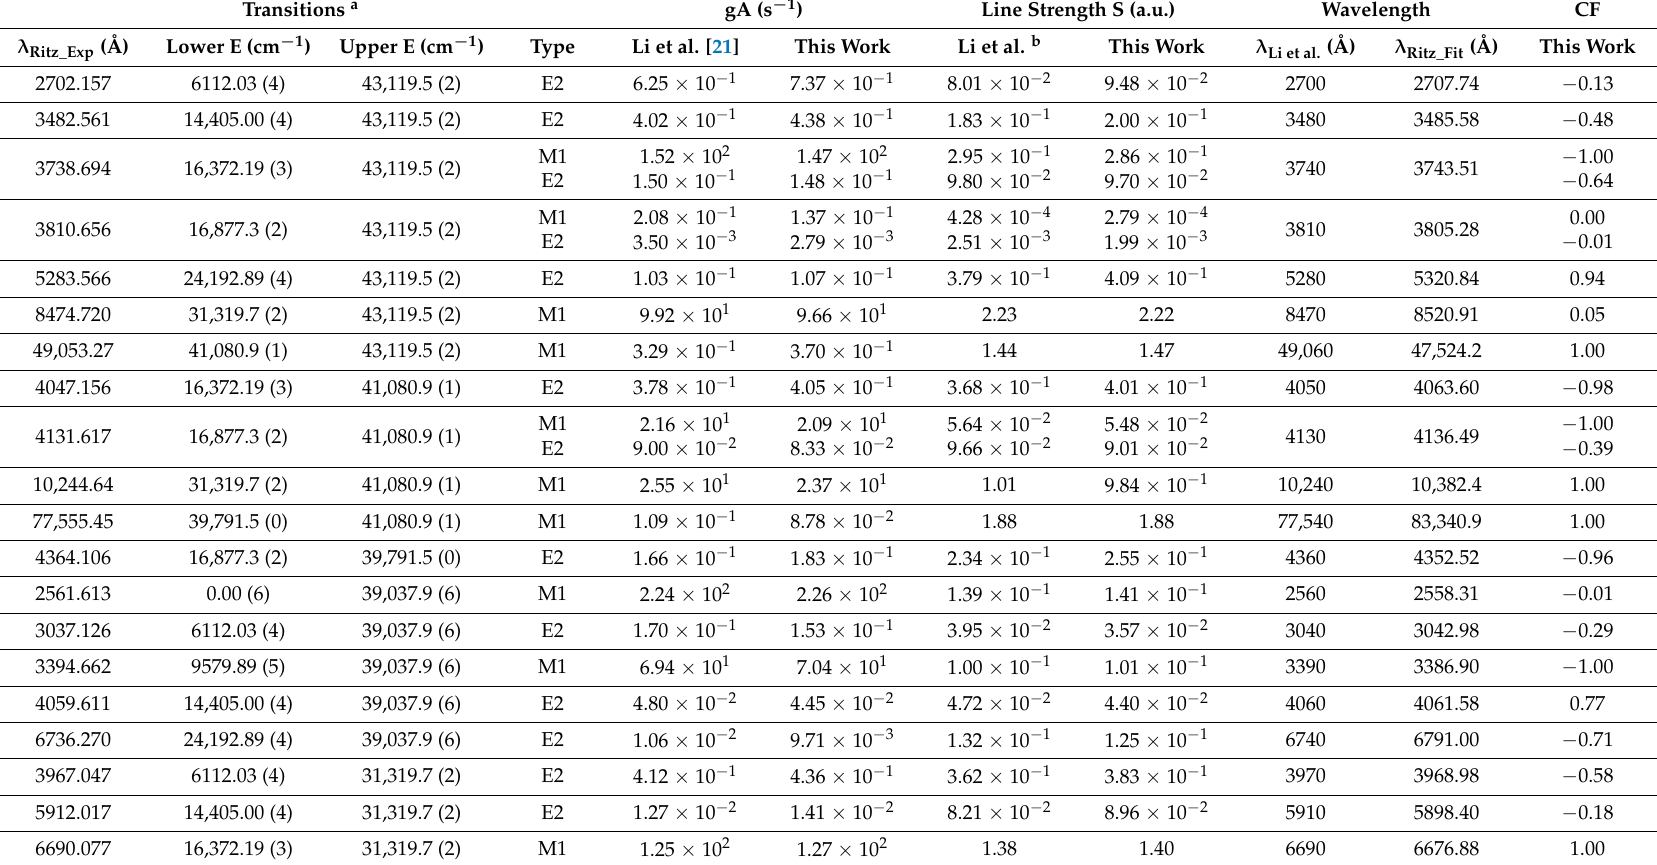
Table 3. Transition probabilities gA (s − 1 ) and line strengths for magnetic dipole (M1) and electric quadrupole (E2) transitions within the Yb V ground-state configuration 4f 12 . Comparison with existing results (ordered by increasing upper level energies). All wavelengths are in vacuum. CF is the cancellation factor as defined by Equation (14.107), p. 432 in [15], and derived from our